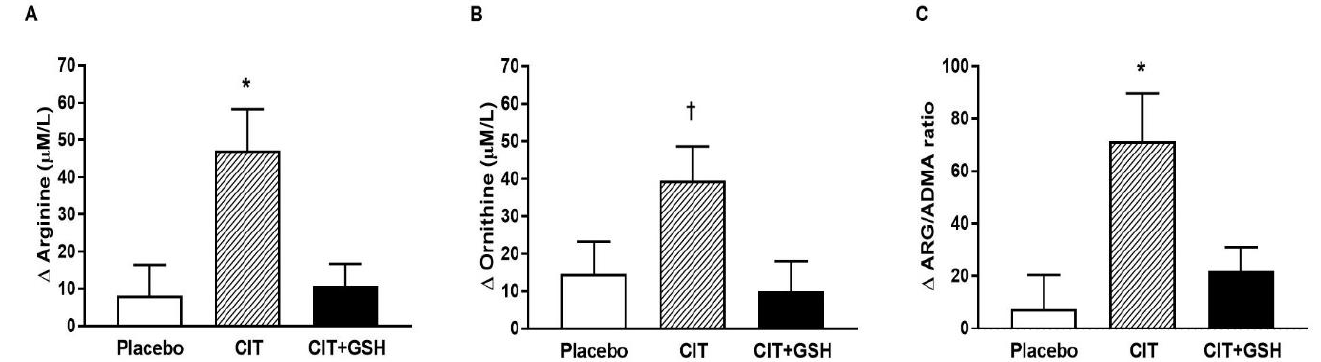
Figure 5. Changes ( ∆ ) in serum levels of arginine ( A ), ornithine ( B ), and the arginine/ADMA ratio ( C ) from 0–4 weeks in the three groups. Values are the mean ± SE. Abbreviations: ARG, arginine; ADMA, asymmetric dimethylarginine; CIT, citrulline; CIT+GSH, CIT+glutathione. * p < 0.05 vs. placebo and CIT+GSH; † p < 0.05 vs. CIT+GSH.